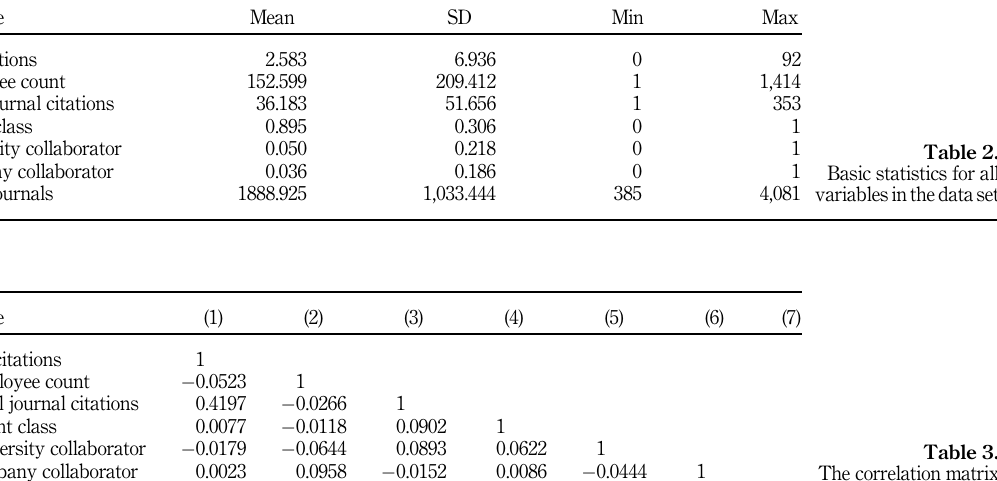
Table 3. The correlation matrix